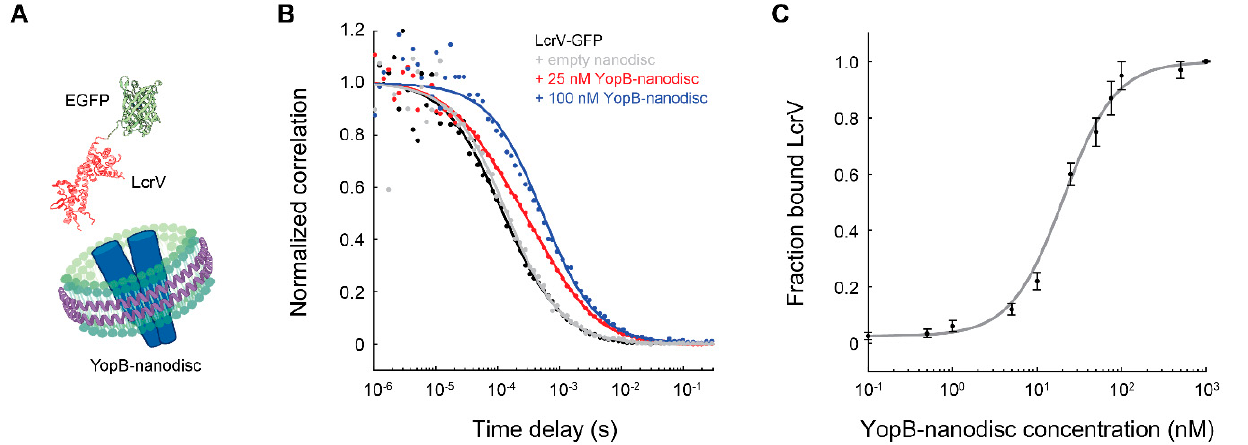
Figure 3. Binding of nanodisc-embedded membrane proteins to smaller, fluorescently labeled ligands are easily detectable by FCS due to a large change in diffusion time. ( A ) Cartoon of the Y. pestis membrane protein YopB (a multimer) inserted into a 10 nm nanodisc and its cognate protein LcrV (PDB: 1R6F) labeled with EGFP. ( B ) FCS correlation curves of LcrV-EGFP in the presence of different concentrations of YopB-nanodisc (data selected from Ly et al. [89]). Addition of YopB-nanodisc shifts the correlation curve of LcrV-EGFP to the right. Intermediate concentrations of YopB-nanodisc result in a diffusion curve with two species present, one of free LcrV-EGFP and one bound to YopB-nanodisc. Curves are fitted to Equation (2) to obtain the diffusion times and fractions of the two species. ( C ) Fraction of LcrV-EGFP bound to YopB-nanodisc at different YopB-nanodisc concentrations. A fit to the Hill equation gives dissociation constant K D = 20 ± 2 nM and Hill coefficient n = 1.4